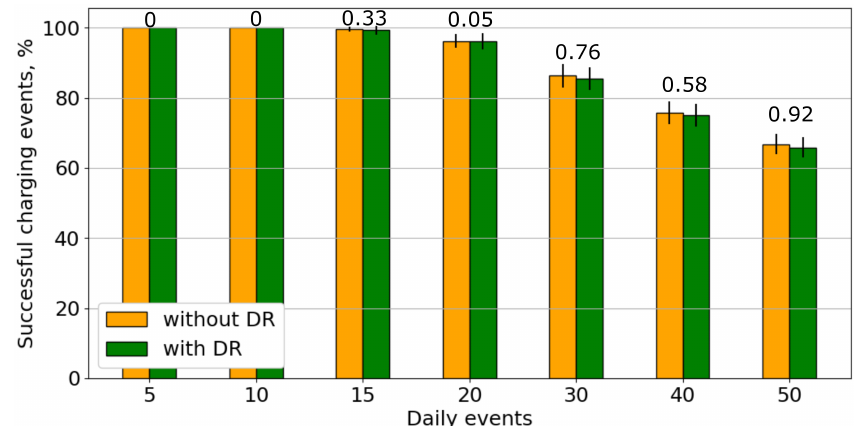
Figure 12. The effect of a DR event on the average value of successful charging events during the day for a building with 8 chargers, 11 kW each. DR event power reduction is 30% for 1 hour from 10:00 to 11:00 with 50 to 50% of time- and energy-based events, respectively. Black vertical bars indicate a 95% confidence interval of the mean value. The difference is presented on